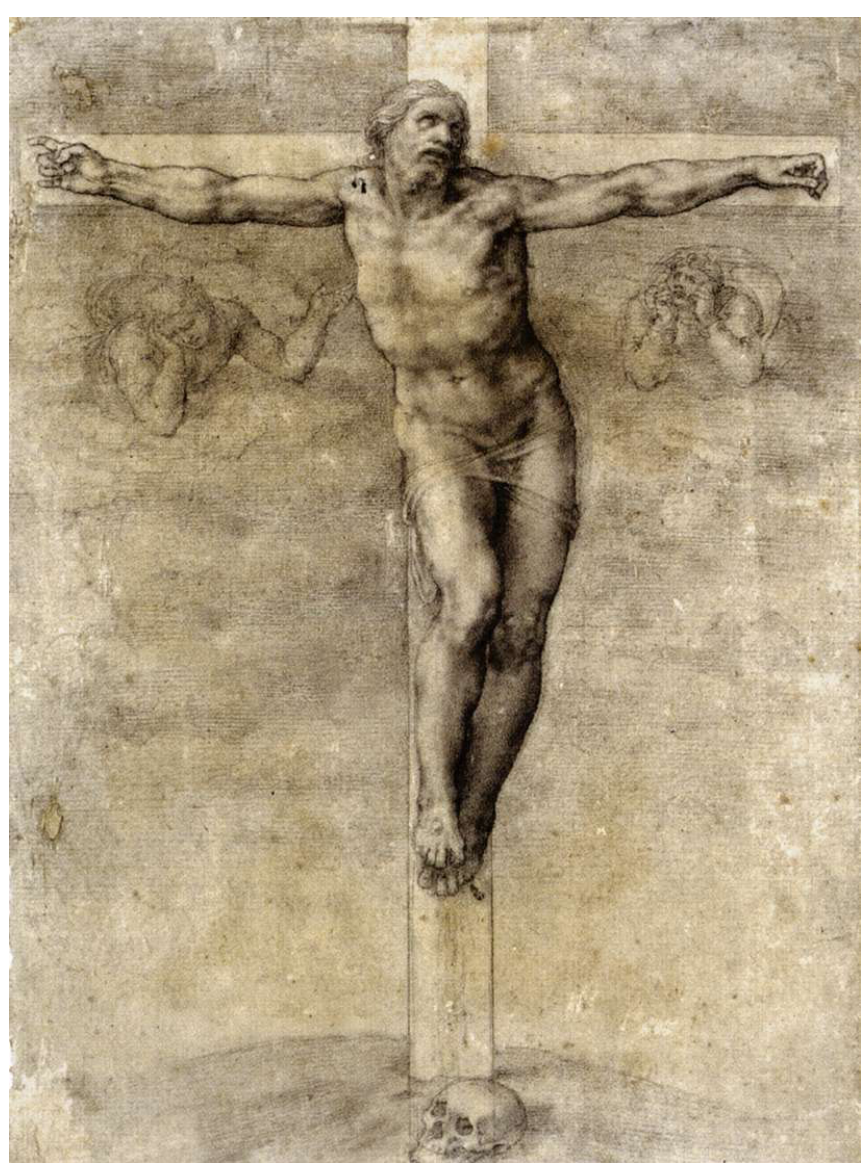
Figure 1: Christ on the Cross , Michelangelo, chalk drawing, circa